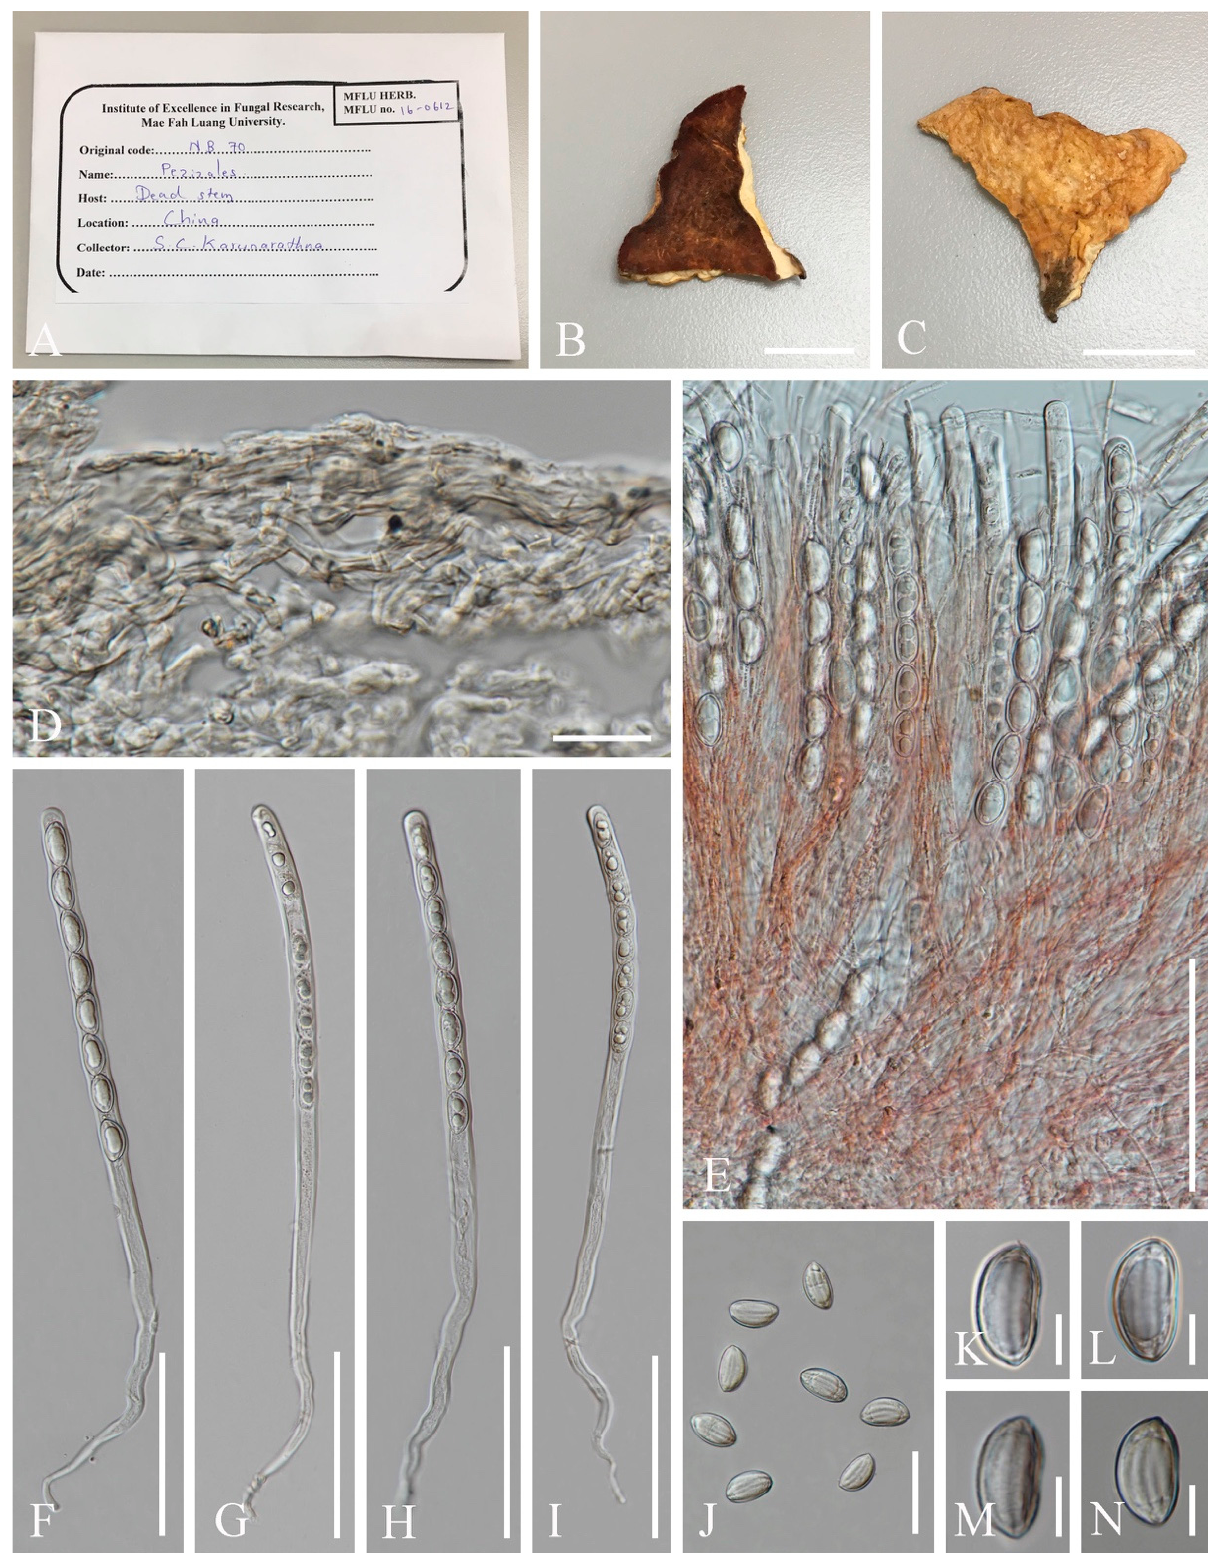
Figure 17. Phillipsia subpurpurea (MFLU16-0612). ( A – C ) Herbarium materials. ( D ) Vertical section of receptacle ectal excipulum. ( E ) Hymenium. ( F – I ) Asci and ascospores. ( J – N ) Ascospores. Scale bars ( B , C ) = 1 cm; ( D ) = 20 μ m; ( E – I ) = 100 μ m; ( J ) = 40 μ m; ( K – N ) = 10 μ m. 7. Pithya villosa M. Zeng, Q. Zhao & K.D. Hyde, sp. nov.; Figure 18 Index Fungorum number: IF 559929; Facesoffungi number: FoF 10411 Etymology: The specific epithet refers to villose receptacle surface. Holotype: HKAS 104653 Diagnosis: This species is diagnosed by shallowly cupulate to discoid, or convex apothecia growing on Juniperus sp., yellowish excipular surface covered with hyphoid hairs, entire or lobate margin, subhyaline to yellowish paraphyses, spherical ascospores with granular contents.